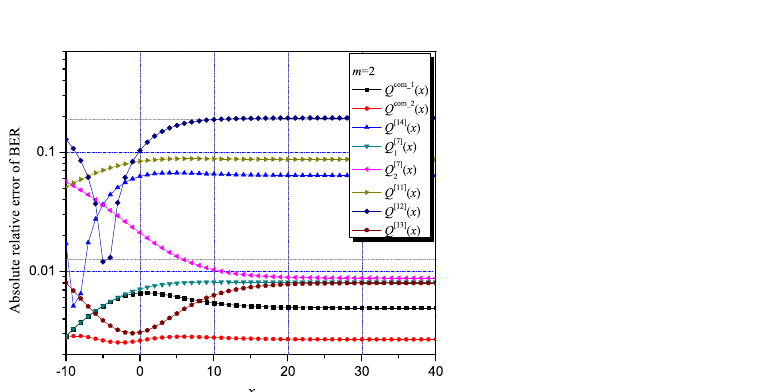
Figure 4. Absolute relative error of determining ASEP for BPSK modulation: comparison of the applied proposed approximations and the selected ones from the